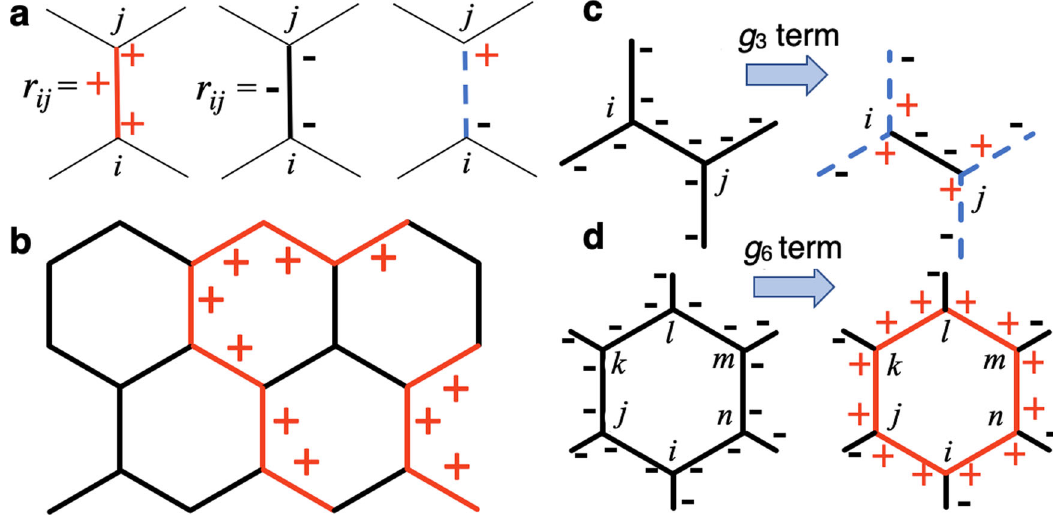
Þ ¼ sgn ð p ð α Þ Þ , which is de fi ned in the ground-state i j